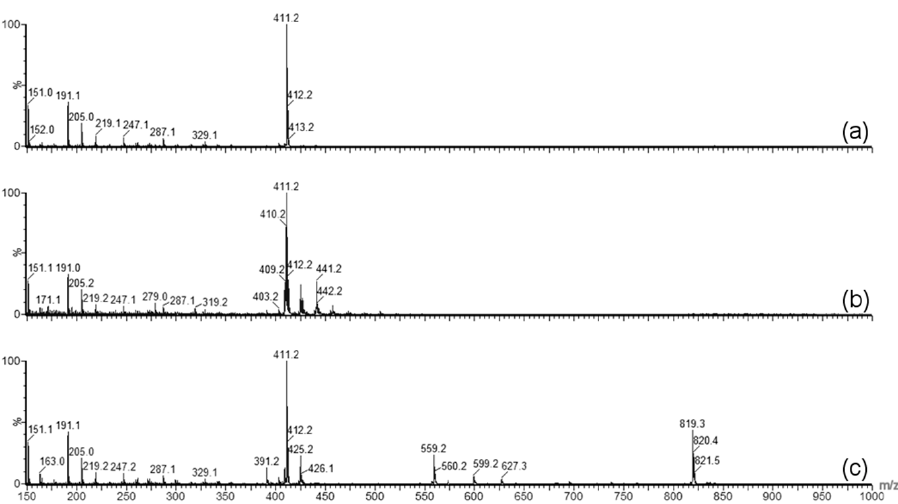
Figure 7. Atmospheric pressure chemical ionization (APCI) mass spectrum of ( a ) GT3; ( b ) peroxide-degraded GT3; and ( c ) heat-degraded GT3. The heat-degraded sample exhibits the presence of GT3 dimer at 819.3 m/z and the reddish brown color observed in aged liquid NE samples.